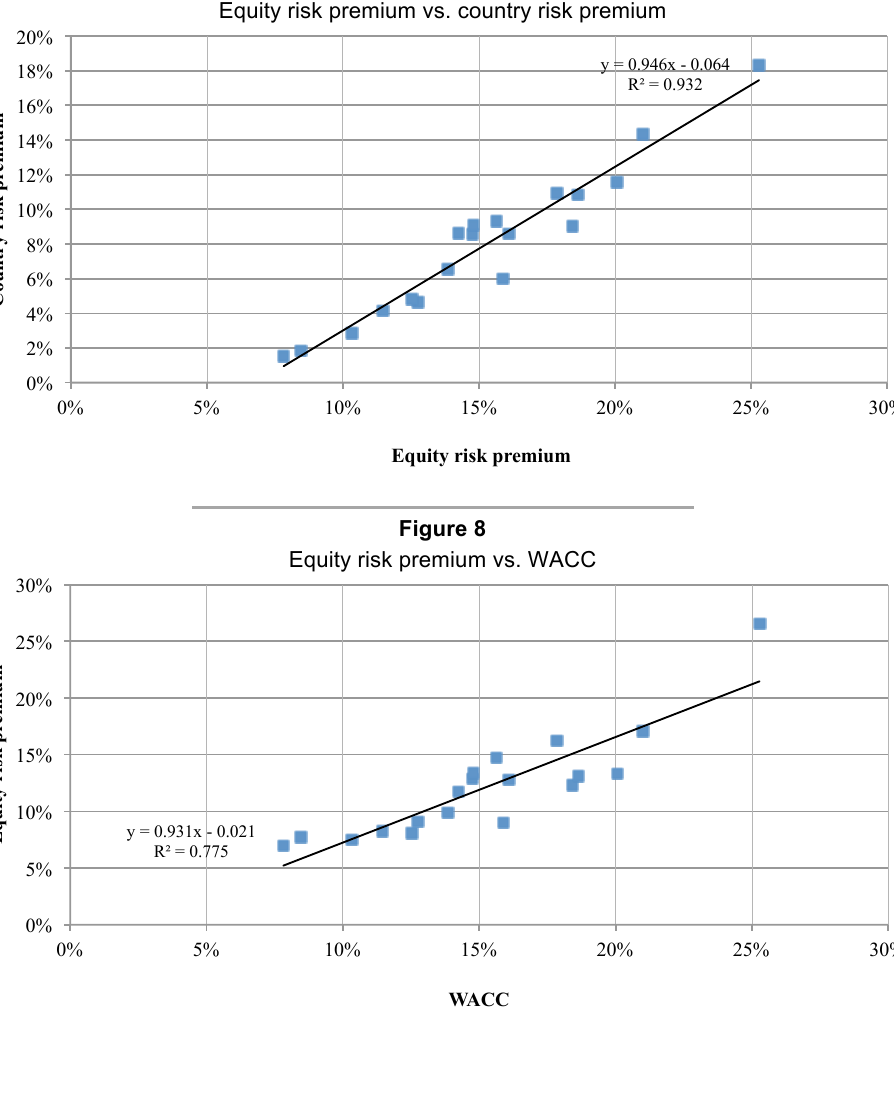
Equity risk premium vs. country risk premium